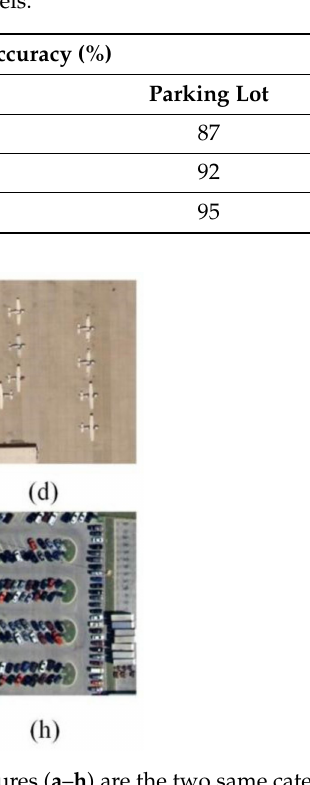
Table 8. Accuracy of two categories classified with three models.